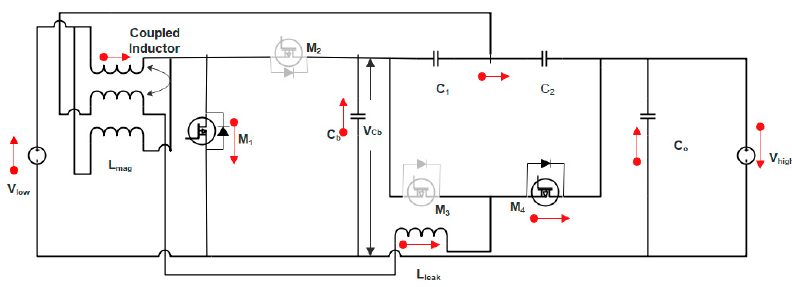
Figure 4. Equivalent circuit for mode II.